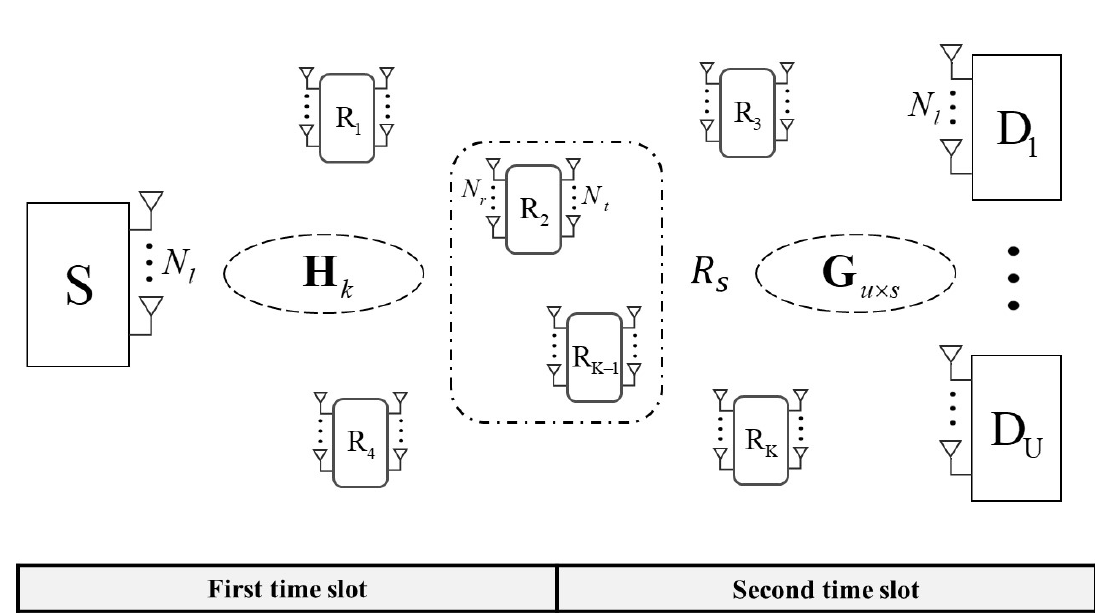
Figure 1. Two-hop MIMO relaying